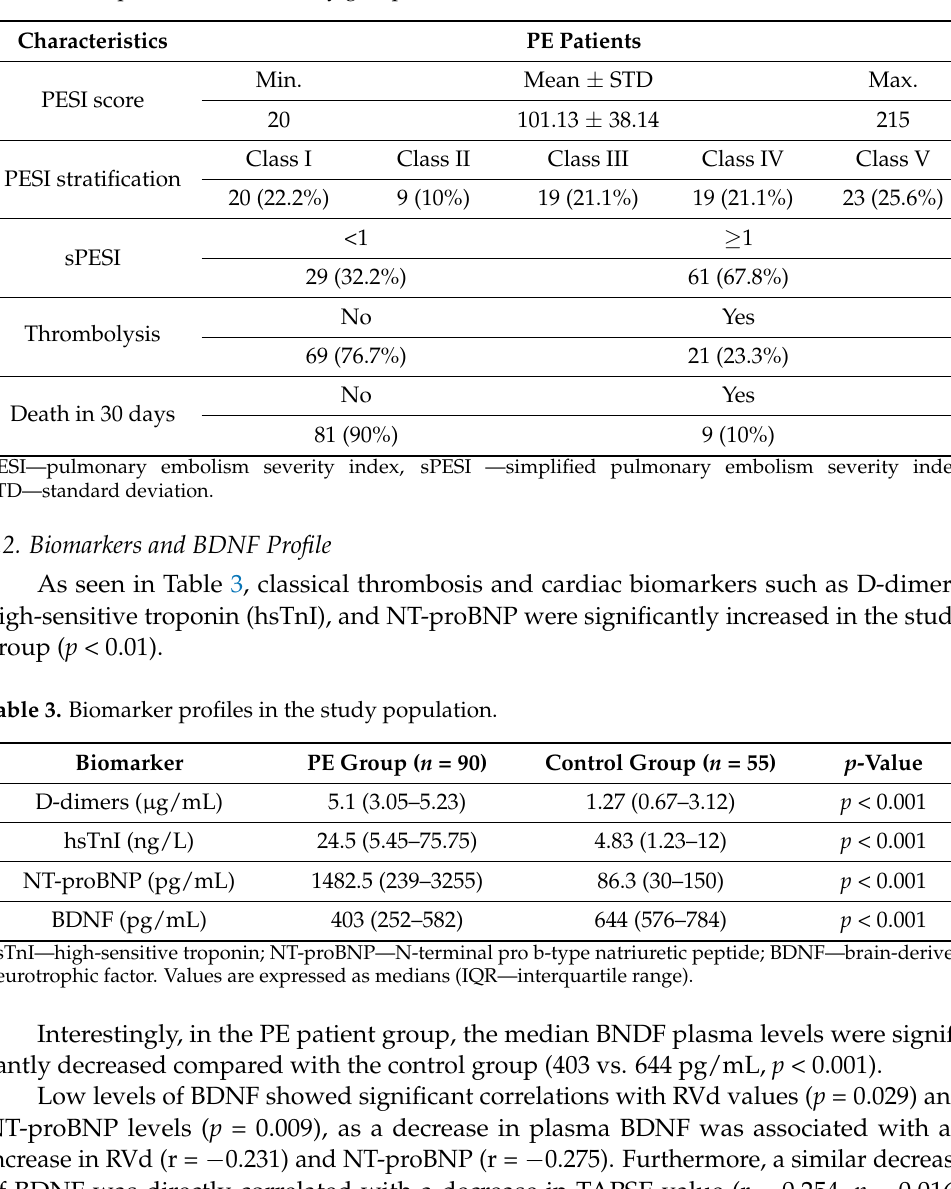
Table 2. Risk profile of the PE study group.